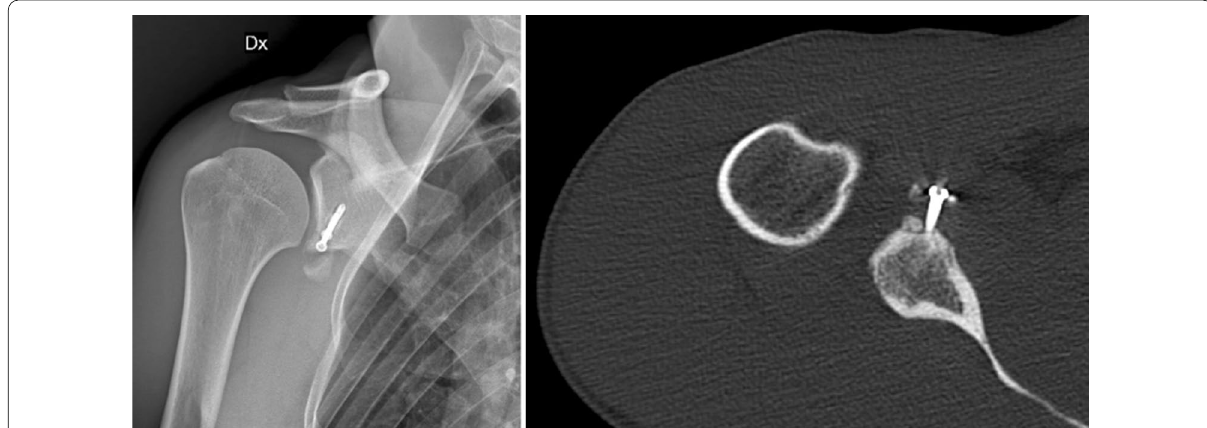
Fig. 1 Graft lysis and partial